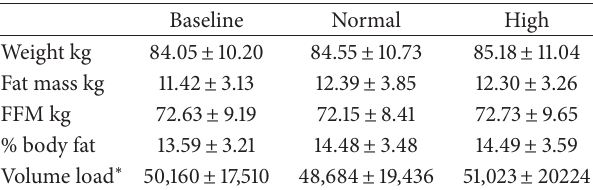
Table 1: Body composition and training